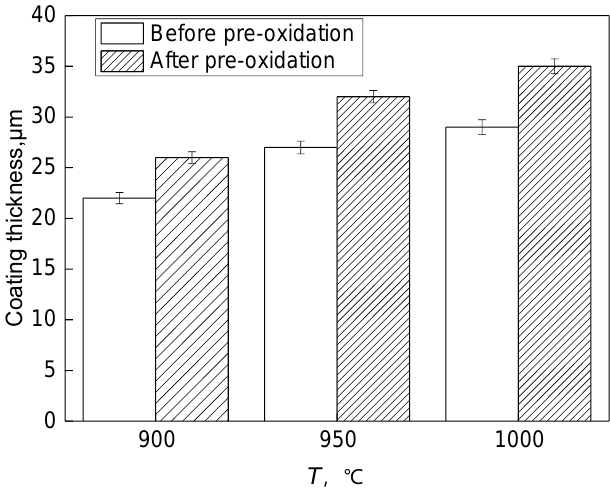
Figure 5. Thickness of Al-Si coating after pre-oxidation at different pre-oxidation temperature for 1 h.